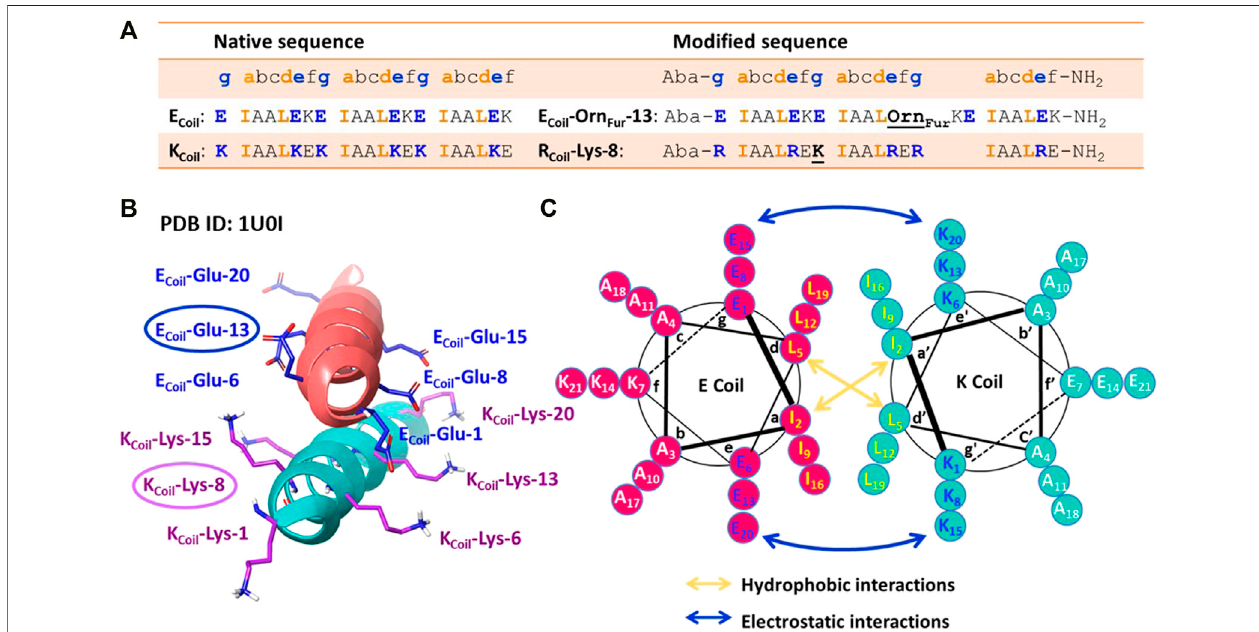
FIGURE 3 | (A) Peptide sequences of the native [(EIAALEK)3/(KIAALKE)3] and modi fi ed coiled-coil complex. Peptide sequences are written N-terminus to C- terminus. The four amino acids (IAAL) in the peptide sequence correlate with the positions a, b, c, and d of the coiled-coil heptad repeat (abcdefg), and EKE (ECoil) or KEK/RER (K/RCoil) correlate with the e, f, and g positions. An Aba (aminobenzoic acid) group is introduced at the N-terminus and NH2 indicates the amide group at the C-terminus. (B) Crystal structureofthe (EIAALEK)3/(KIAALKE)3 coiled-coil heterodimer inwhich thepartnermoietiesofinterest(Ecoil: Gluat position13and Kcoil: Lys at position 8) are indicated. PDB ID: 1U0I. (C) Helical wheel representation of the (EIAALEK)3/(KIAALKE)3 coiled-coil heterodimer viewed in cross-section. The interhelical hydrophobic interactions are denoted with orange arrows, and interhelical electrostatic interactions are denoted by the blue